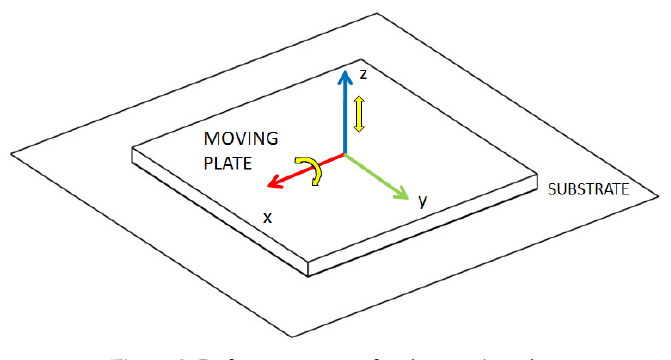
Figure 2: Reference system for the moving plate.